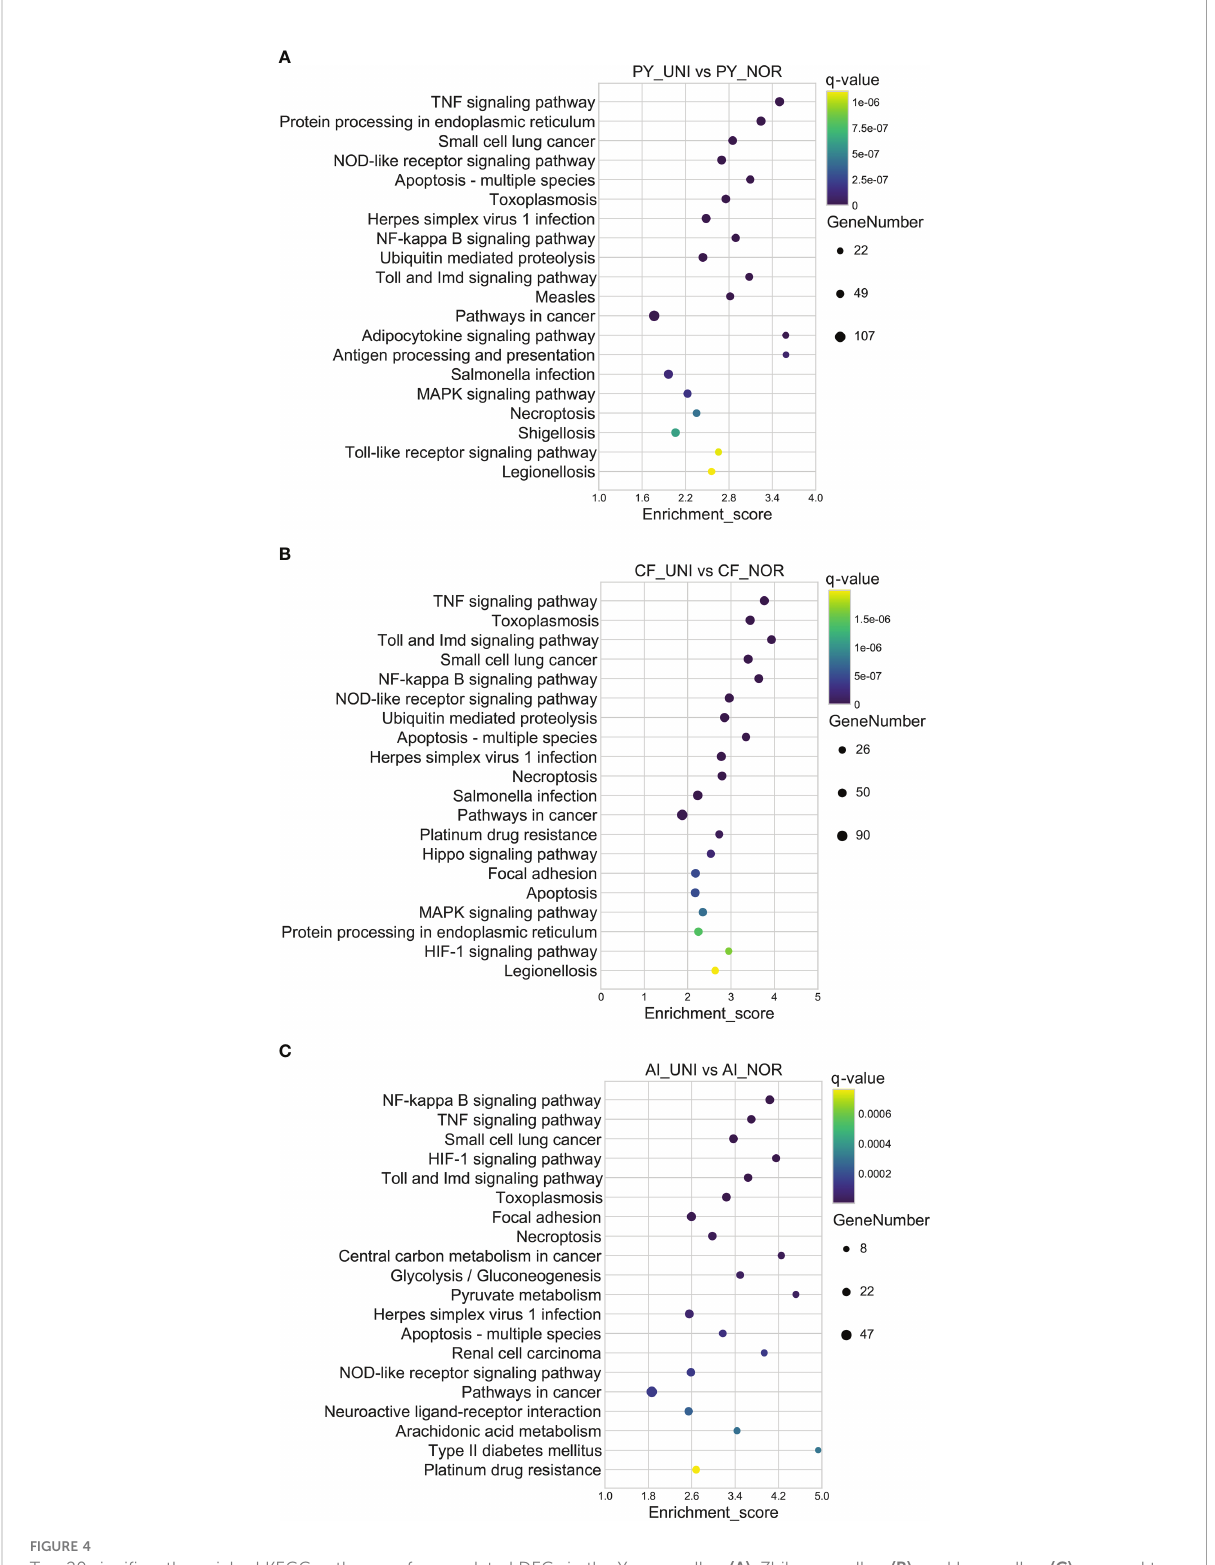
FIGURE 4 Top 20 signi fi cantly enriched KEGG pathways of upregulated DEGs in the Yesso scallop (A) , Zhikong scallop (B) , and bay scallop (C) exposed to heat and hypoxia. (PY, Patinopecten yessoensis ; CF, Chlamys farreri ; AI, Argopecten irradians ; UNI, heat + hypoxia stress at 25°C and 2 mg/L DO; NOR, normal conditions at 15°C and 8 mg/L